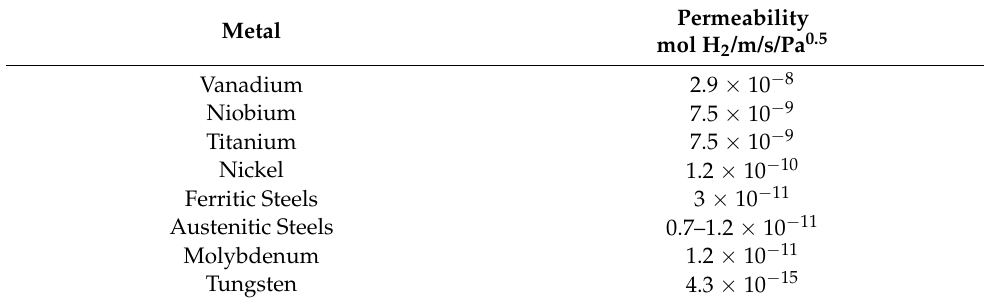
Table 1. Hydrogen permeability of selected metals at 500 ◦ C